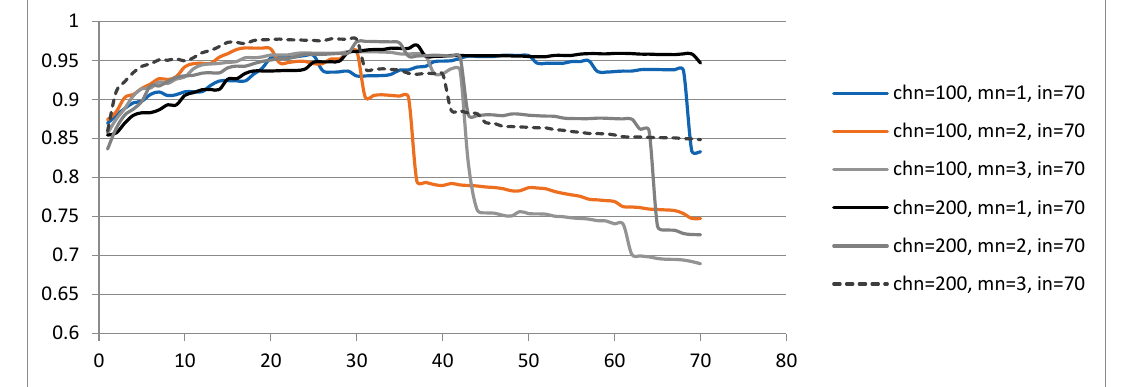
Figure 6. The mean scalar function obtained in each iteration for the simulation described by {chn, mn, in = 70}.